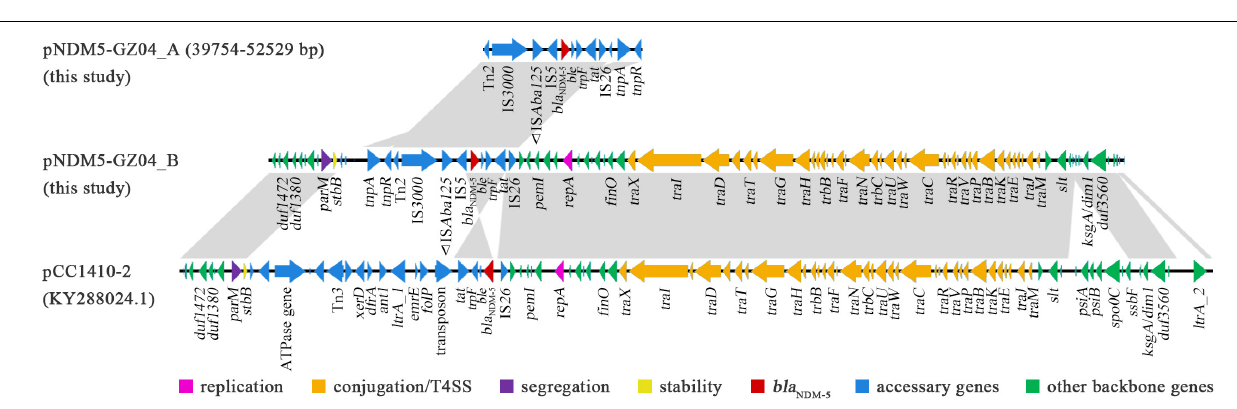
Frontiers in Microbiology |